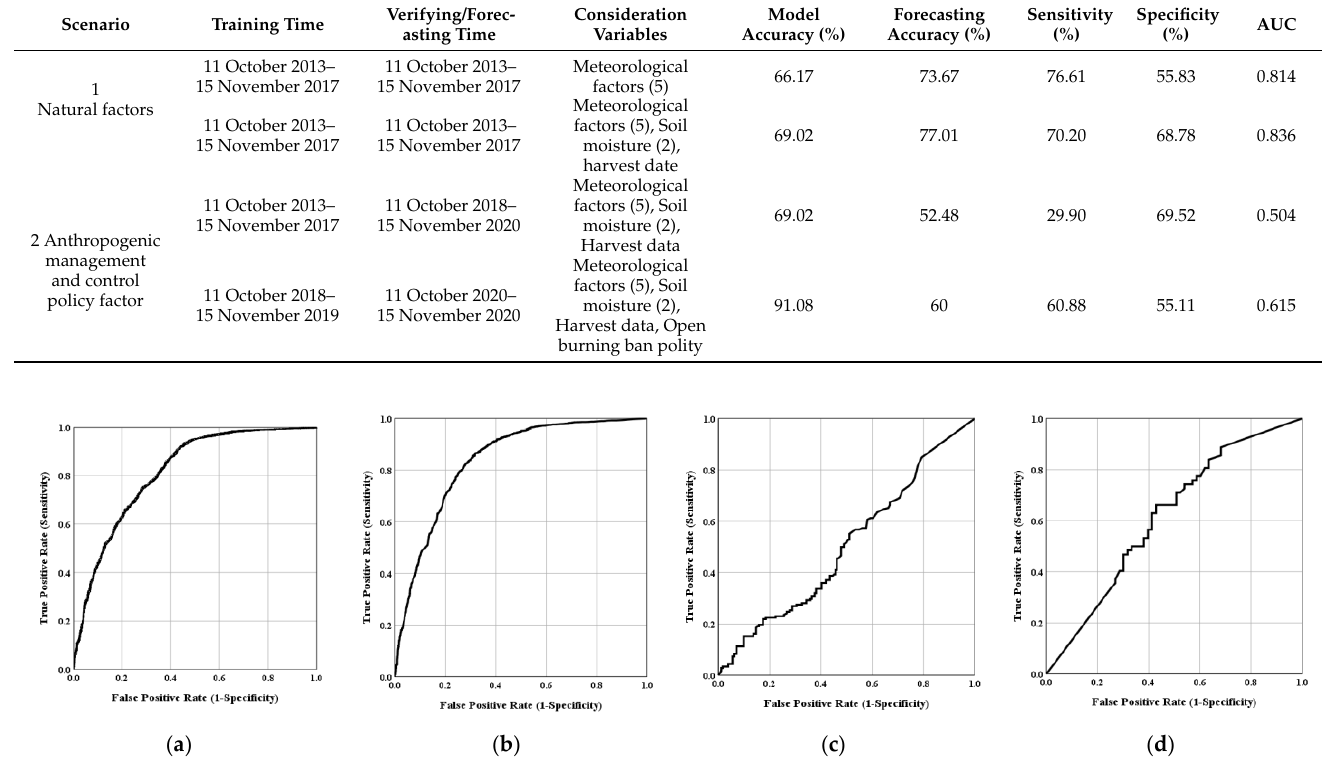
Table 7. Information about the accuracy, sensitivity, specificity and AUC of the model and forecasting in the two scenarios of this study (AUC: the areas under ROC curves).